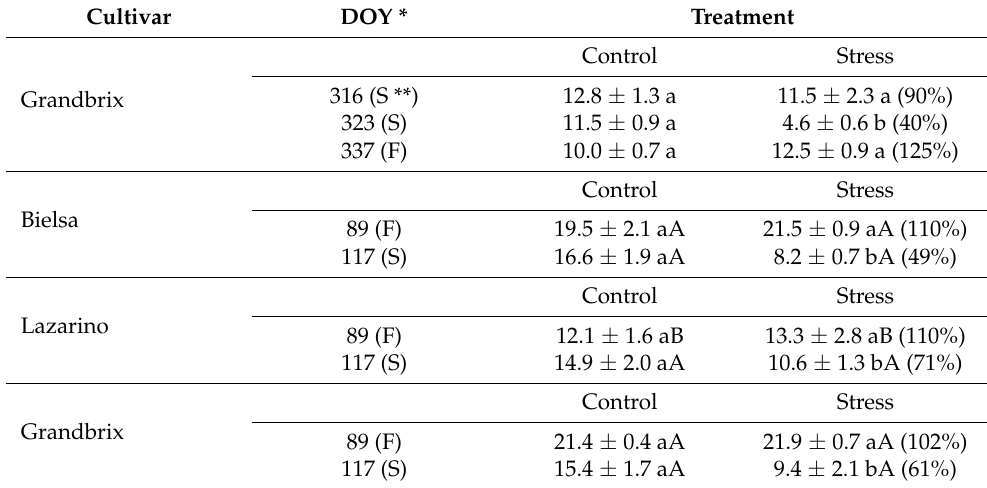
Figure 3. Pattern of midday leaf water potential during both experiments. Each symbol is the average of 4 (autumn cycle) or 3 (spring cycle) data. Vertical bars represent the standard error. Asterisks (irrigation treatments) indicate the date when significant differences were found ( p < 0.05). Table 1. Midday net photosynthesis (Pn) measurements in the two experiments (average and standard error). The ratio between stress and control measurements is shown in brackets. Lowercase letters show statistical differences in relation to irrigation treatment, while capital letters indicate cultivars differences (only second experiment) ( p < 0.05).